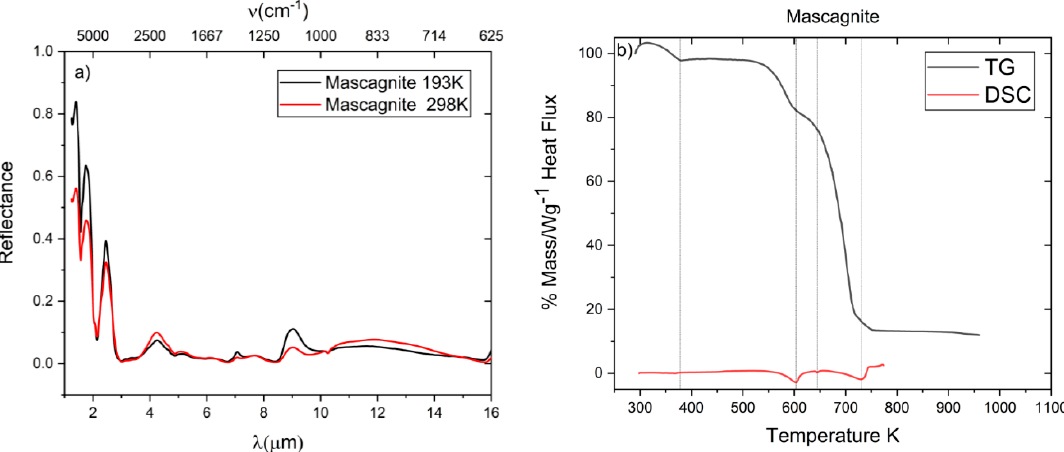
Figure 8. Reflectance spectra at room temperature and 193 K ( a ) and TG/DSC ( b ) analysis from room temperature to 773 and 1023 K of mascagnite.